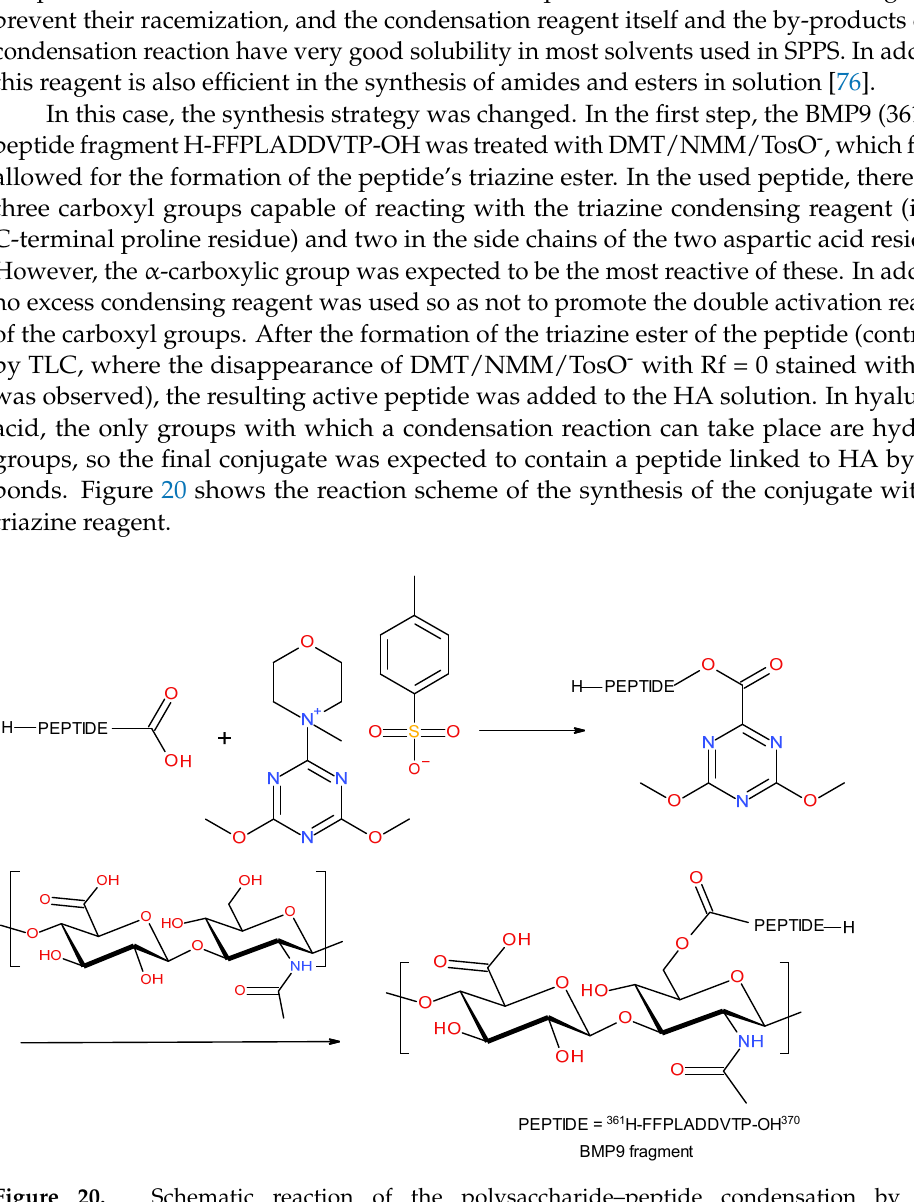
Figure 21. IR spectrum of native HA (black line) vs. HA– FFPLADDVTP conjugate (red line) and the spectrum of the used peptide (blue line).